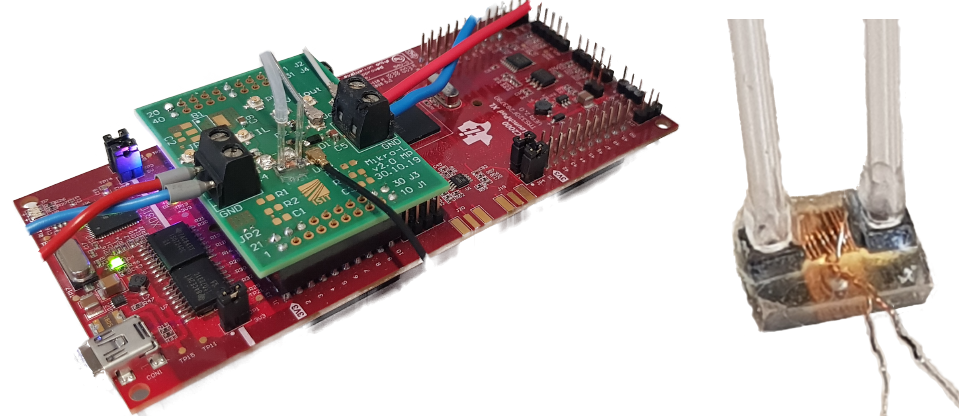
Figure 10. Picture of the DC/DC converter ( left ) assembled with micro-inductor (zoomed: right